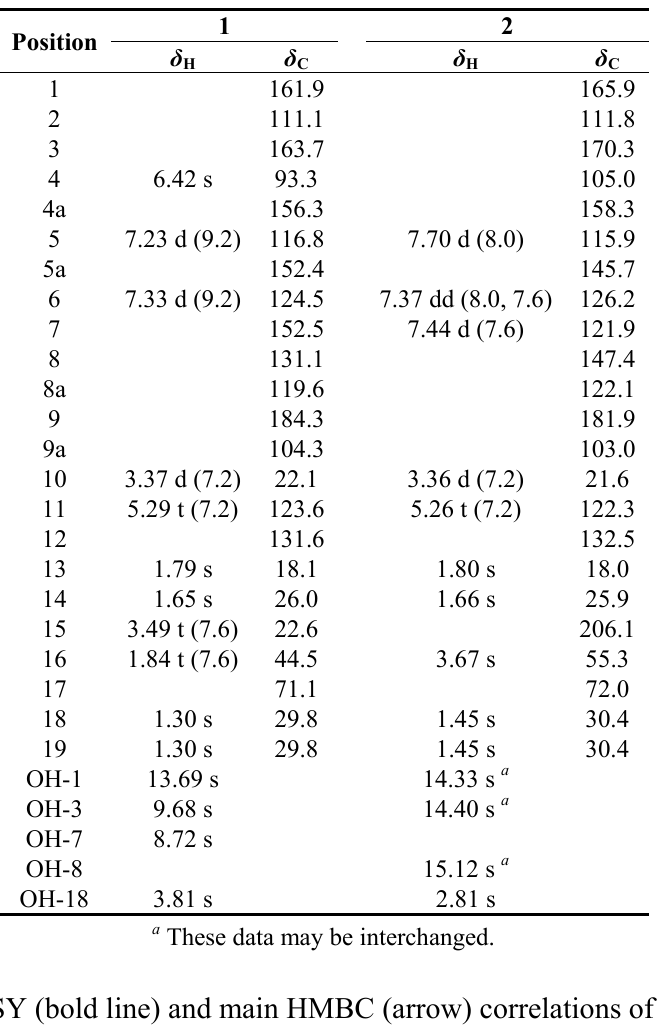
Figure 2. 1 H- 1 H COSY (bold line) and main HMBC (arrow) correlations of compounds 1 and 2 .